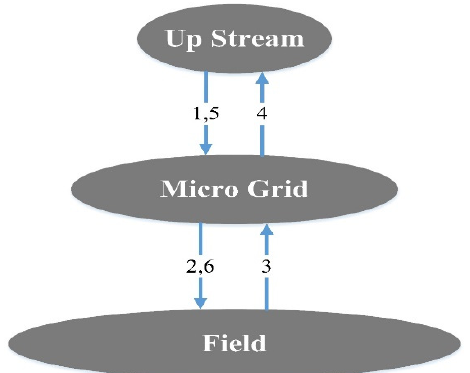
Figure 2. Architecture of the MCS and date exchange.